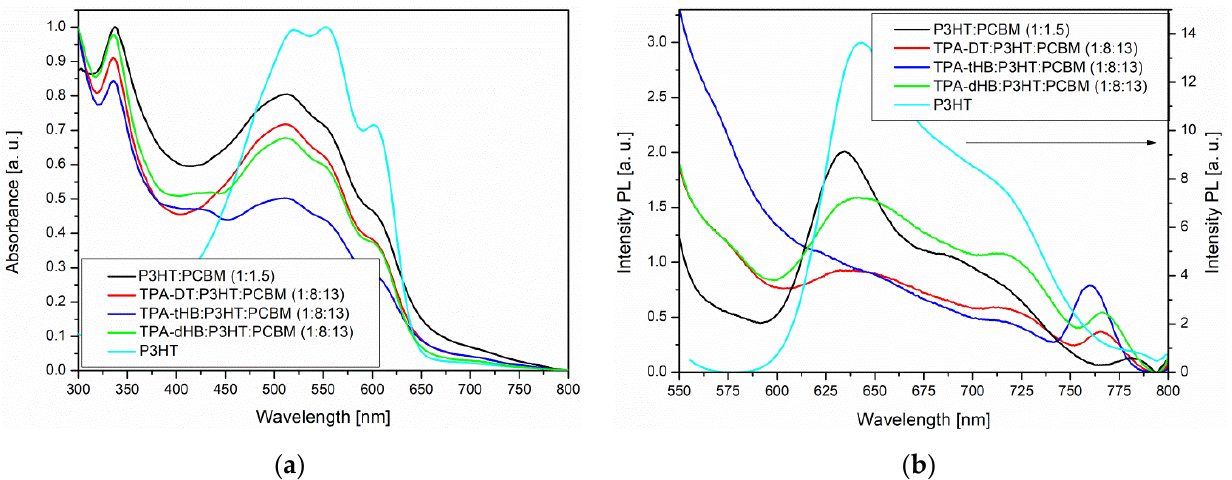
Figure 4. UV – Vis ( a ) and PL ( b ) spectra of imines in blend together with spectra of P3HT and P3HT:PCBM.